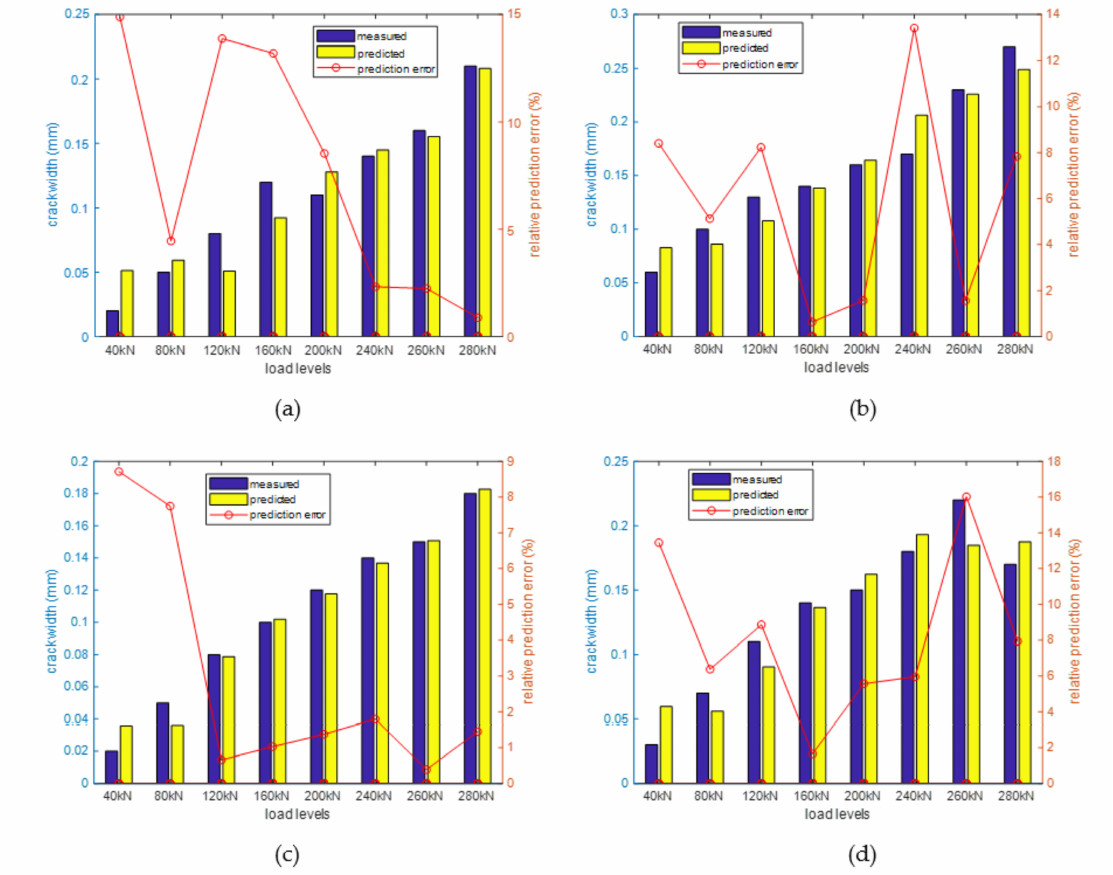
Figure 26. Comparison of the measured and predicted crack widths under di ff erent load levels in the experiment ( a ) crack No. 18 ( b ) crack No. 1 ( c ) crack No. 2 ( d ) crack No.